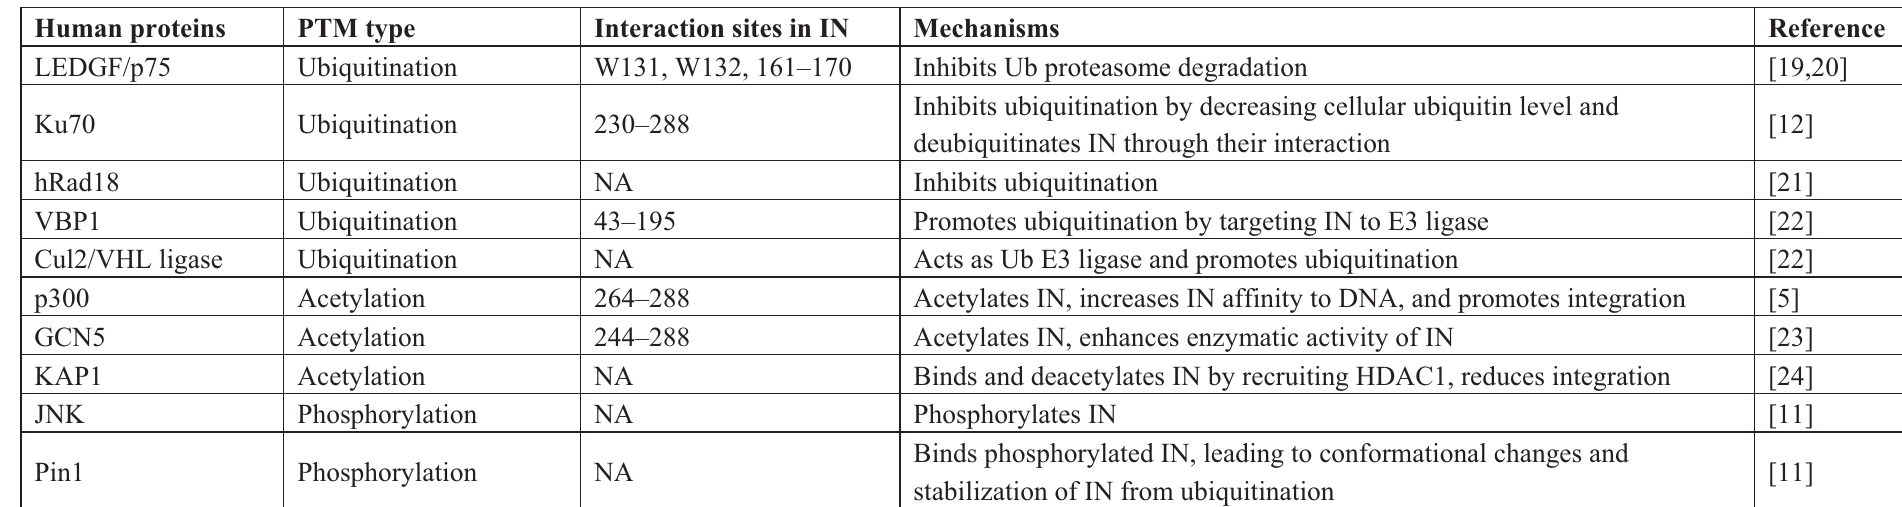
Table 1. Human proteins implicated in the PTMs of